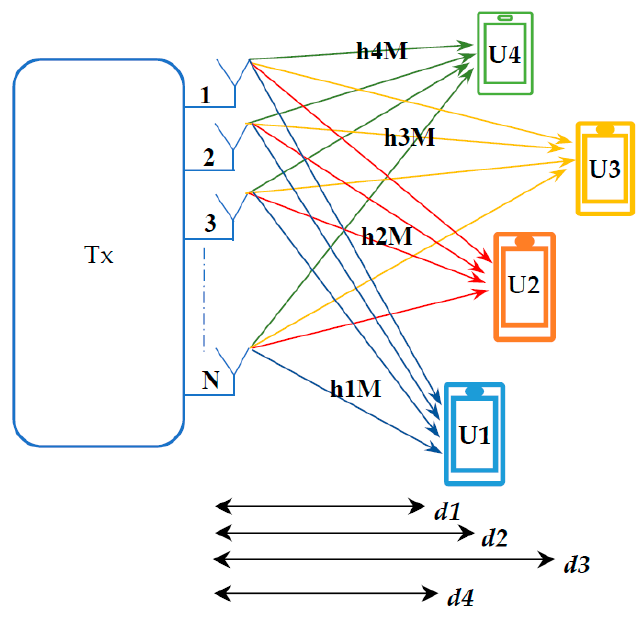
Figure 1. Illustrates the wireless network consisting of 4 users 64 × 64 MIMO-DL-NOMA (power domain).